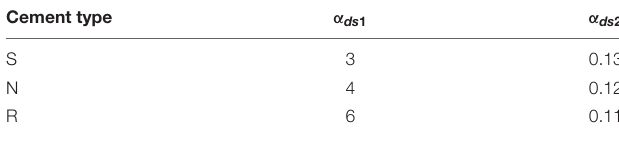
TABLE 2 | Cement type and